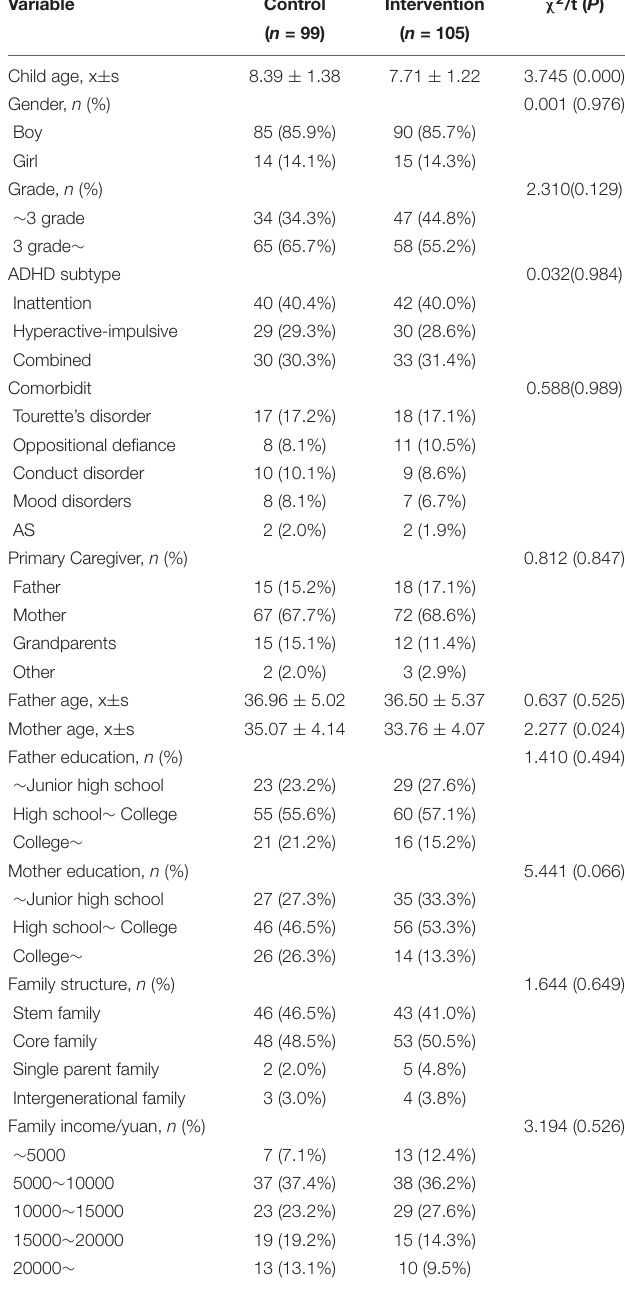
TABLE 1 | Demographic characteristics of intervention group and control